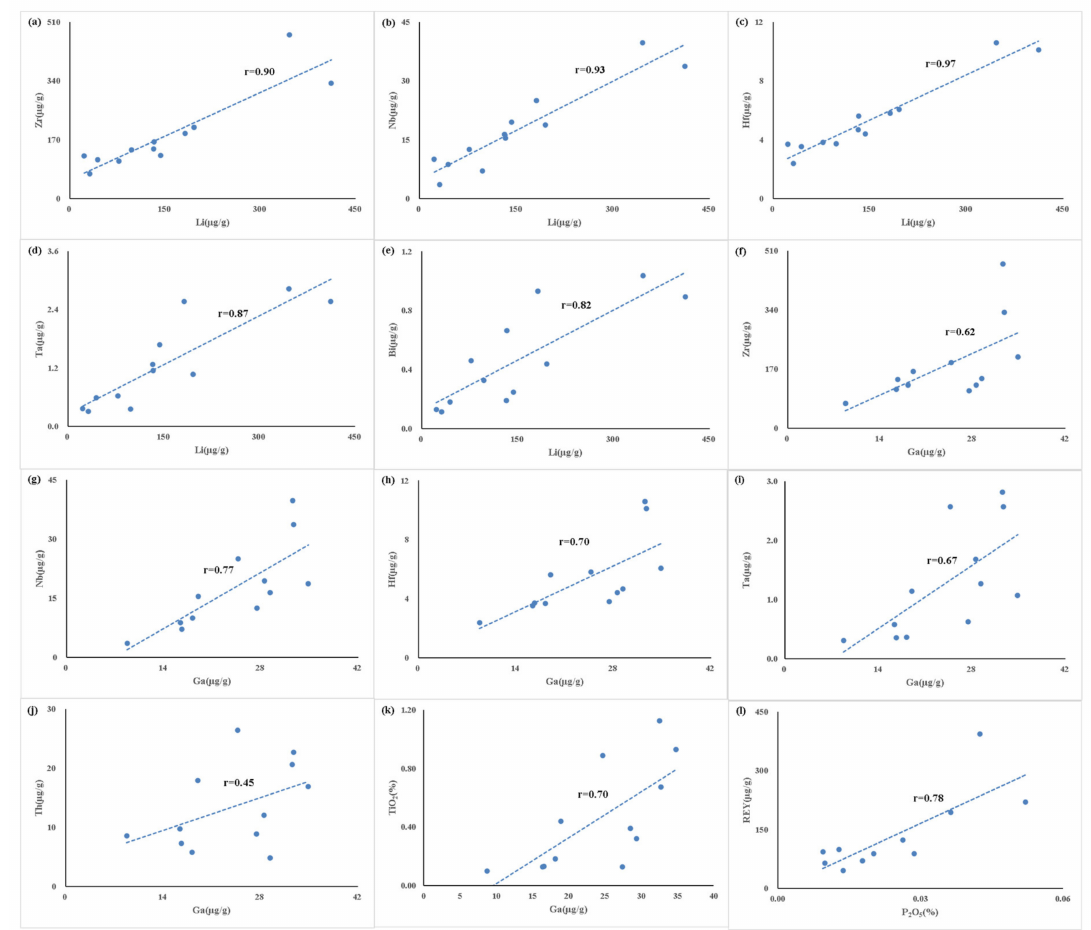
Figure 10. Correlation of: ( a ), Zr to Li; ( b ), Nb to Li; ( c ), Hf to Li; ( d ), Ta and Li; ( e ), Bi to Li; ( f ), Zr to Ga; ( g ), Nb to Ga; ( h ), Hf to Ga; ( i ), Ta to Ga; ( j ), Th to Ga; ( k ), TiO 2 to Ga; and ( l ), REY to P 2 O 5